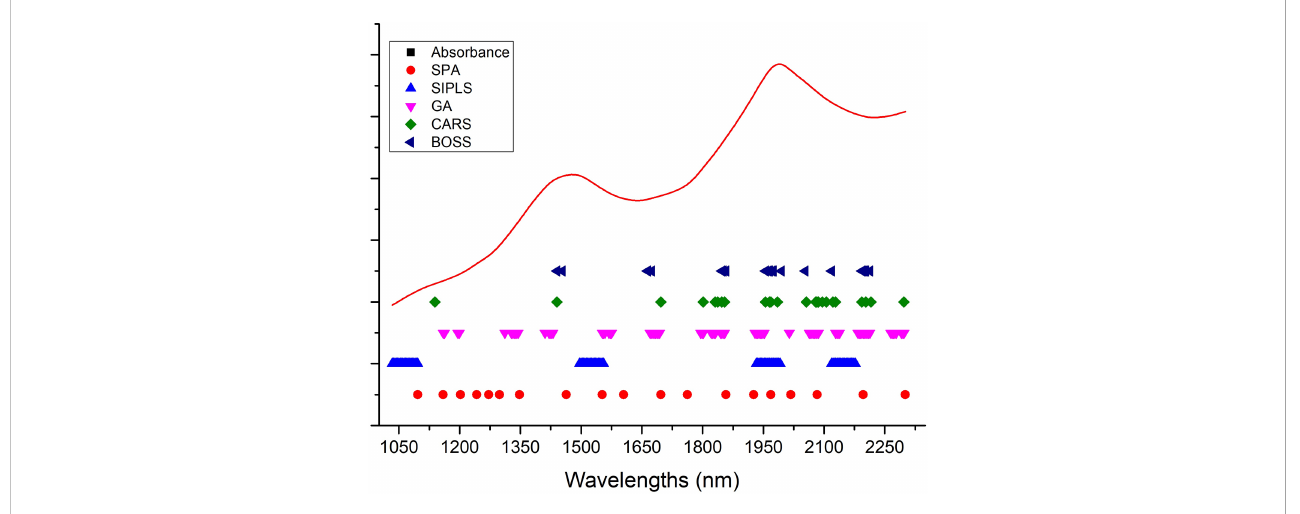
FIGURE 4 Distribution of effective wavelengths selected by SPA, SiPLS, GA, BOSS, and CARS